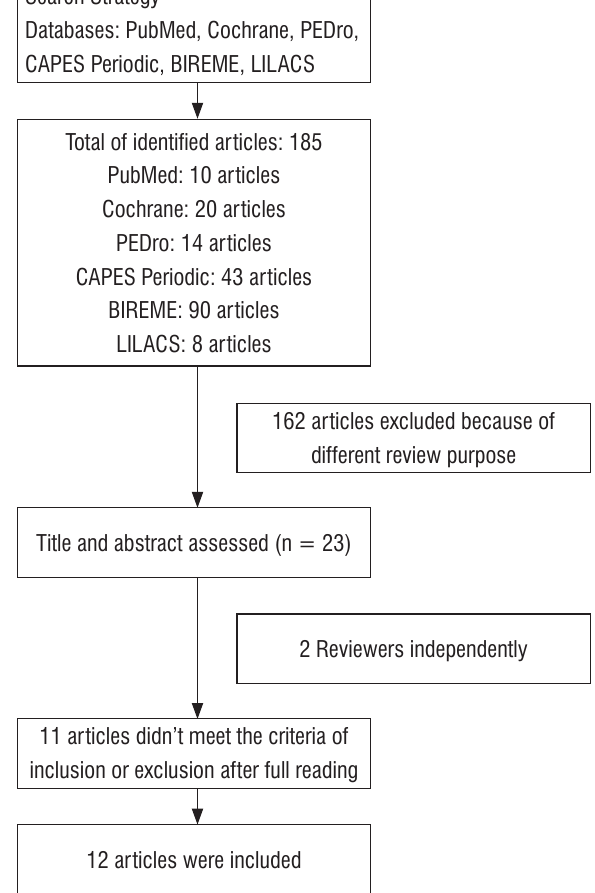
Figure 1 - Flowchart of the survey in electronic